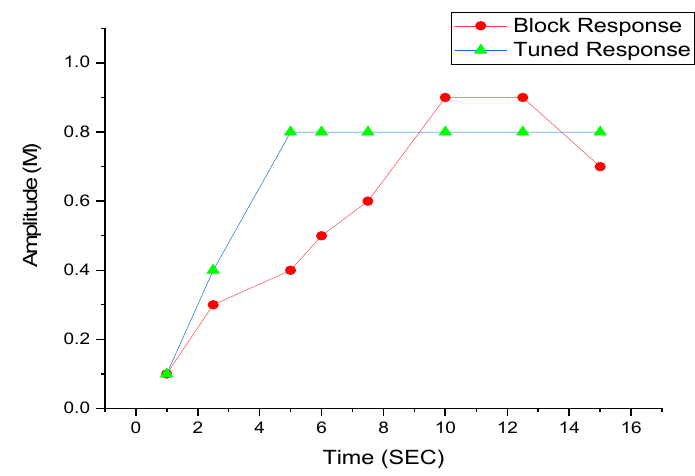
Figure 9. Inverter result from control structure.